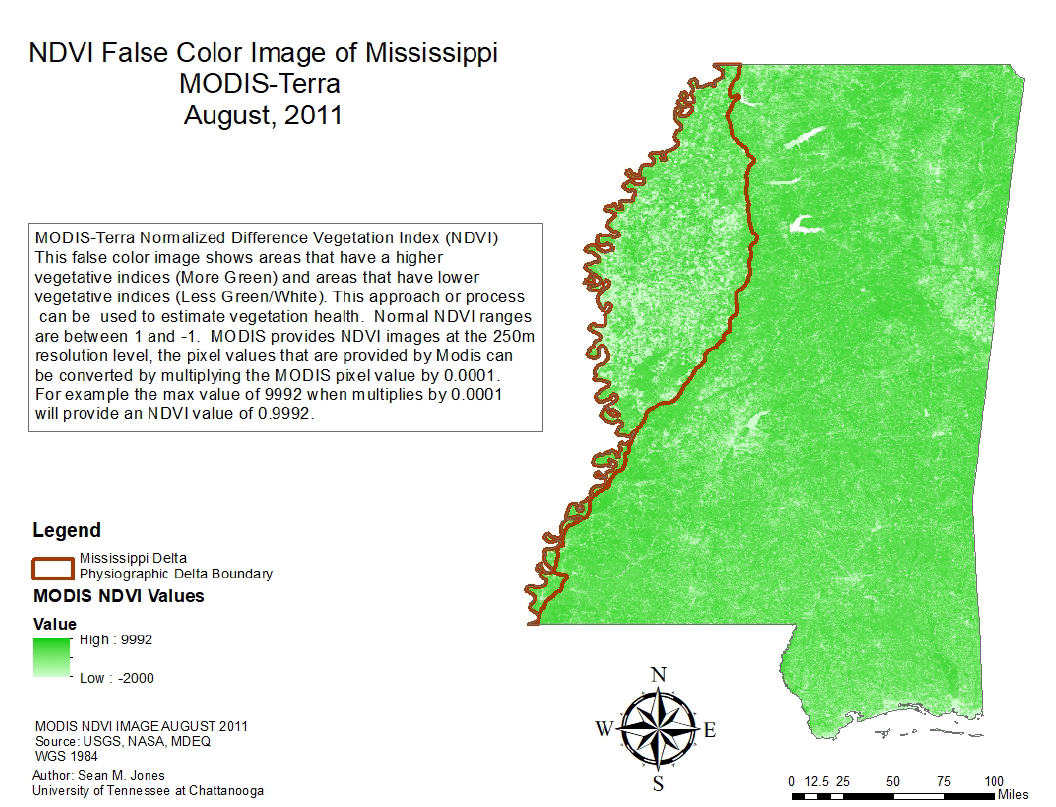
Figure 1. Processed MODIS NDVI data for the state of Mississippi and the Mississippi Delta Physiographic region.